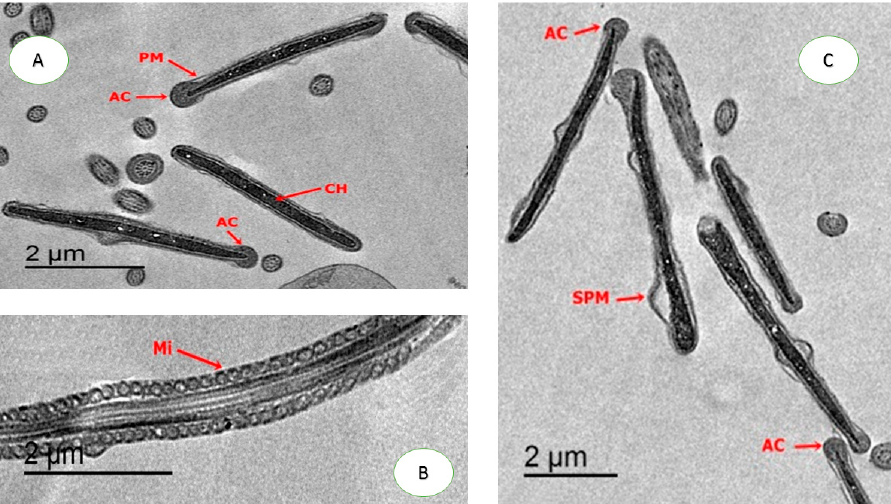
Figure 4. Transmission electron microscopic evaluation. Photomicrographs of sperm head in groups treated with 1.5 µg of CU or CUNPs. ( A ). Normal plasma membrane (PM) with intact head and apical ridge formation (AC) acrosomes and condensed chromatin (CH); ( B ). Early degree of cell membrane extension also was found (SPM) and normal apical ridge formation (AC) acrosomes; ( C ). Mitochondrion was regularly placed in longitudinal sections.